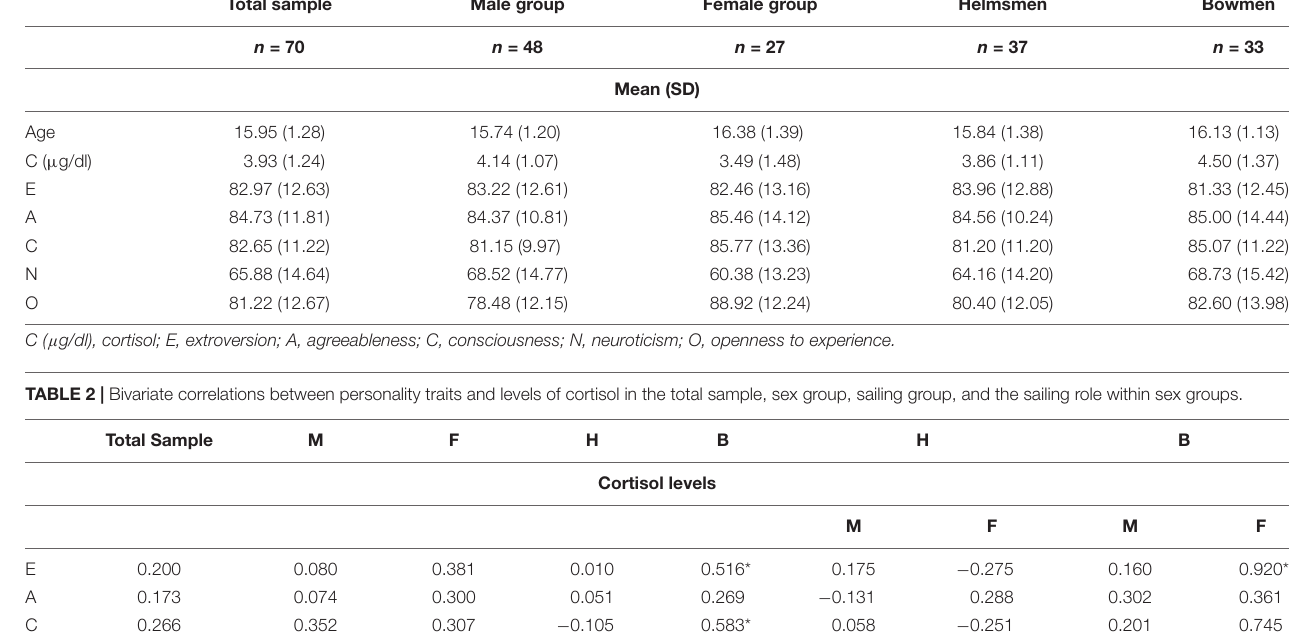
TABLE 1 | Descriptive statistics: Mean and standard deviation for each variable in the total sample, male and female group, helmsmen and bowmen group. Total sample Male group Female group Helmsmen Bowmen